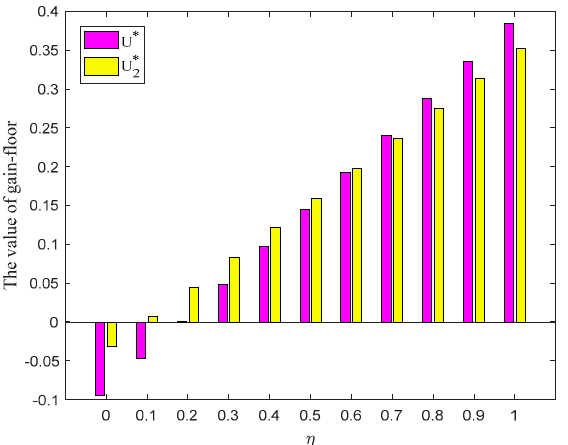
∗ and U ∗ with parameter η varying from 0 to U ∗ with parameter η varying from 0 to1. Figure 10. Gain-floors U 2 2 U ∗ with parameter η varying from 0 to1. 2